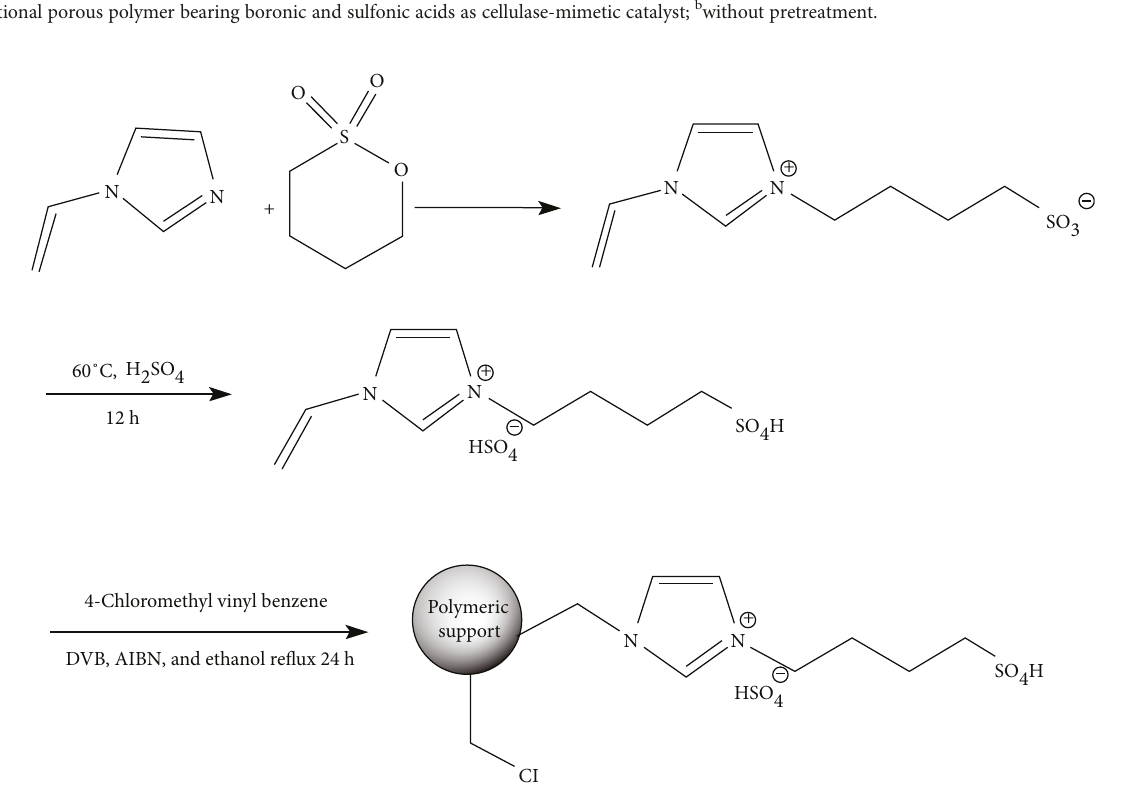
Scheme 3: Schematic diagram of Brønsted acidic ionic liquid catalyst immobilized on 4-chloromethyl vinyl benzene (CMVB) via copolymerization. Adapted from